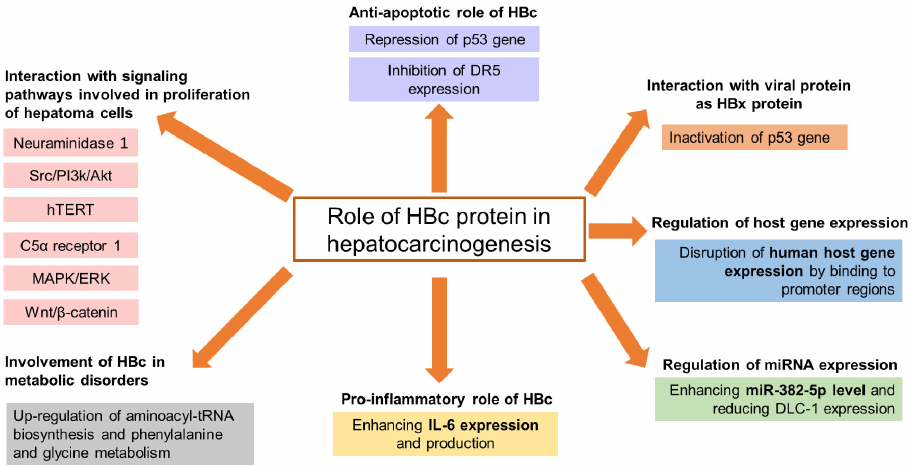
Figure 1. Pleiotropic role of HBc protein in hepatocarcinogenesis. DR5: death receptor 5; NEU1: neuraminidase 1; hTERT: human telomerase reverse transcriptase; C5AR1: C5 α receptor 1; MAPK/ERK: mitogen-activated protein kinase/extracellular signal-regulated kinase; IL-6: interleukine-6; HBV: hepatitis B virus; HCC: hepatocellular carcinoma; DLC-1: deleted in liver cancer. Table 1. Interactions and reported mechanisms of HBc protein on the various pathways (signaling pathways involved in migration and proliferation of hepatoma cells, apoptosis pathways, metabolic disorders, immune system), epigenetic and genetic events. Mechanism of HBc to Promote Group Target Reference Hepatocarcinogenesis